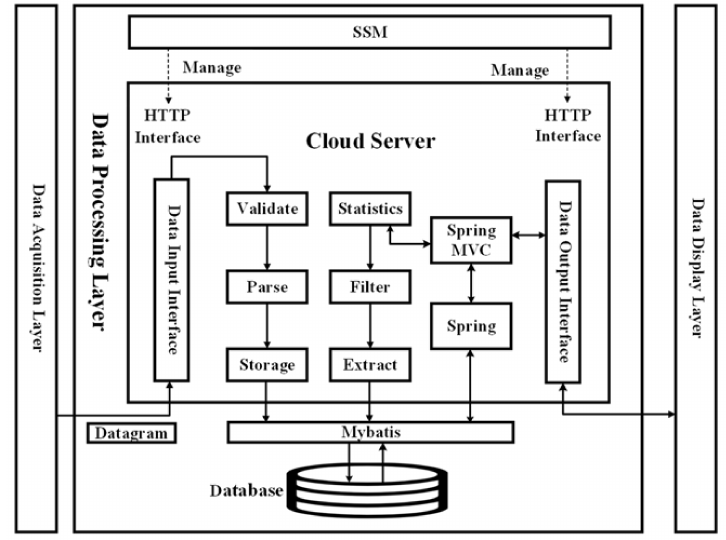
Figure 3. Software architecture